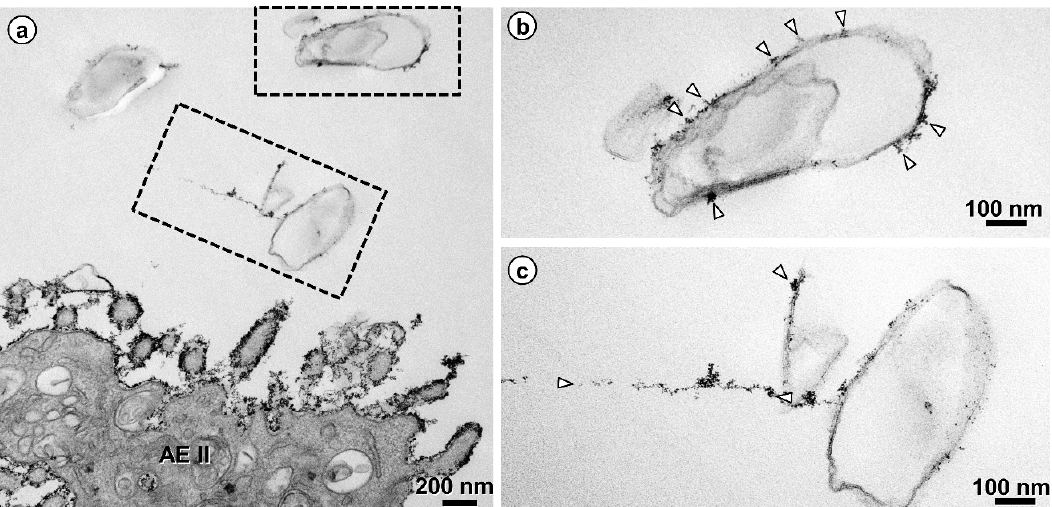
Figure 6. Human lung. Glycocalyx staining on intraalveolar surfactant. ( a ) Intraalveolar surfactant (boxed areas) in the airspace of an alveolus nearby an alveolar epithelial type II (AEII) cell is decorated by thorium dioxide. The boxed areas are shown in ( b , c ) at higher magnification. The stain on the intraalveolar surfactant (arrowheads) is less intense compared to the stain on the AEII cell, rather comparable with the punctual stain on an AEI cell (compare Figure 4).